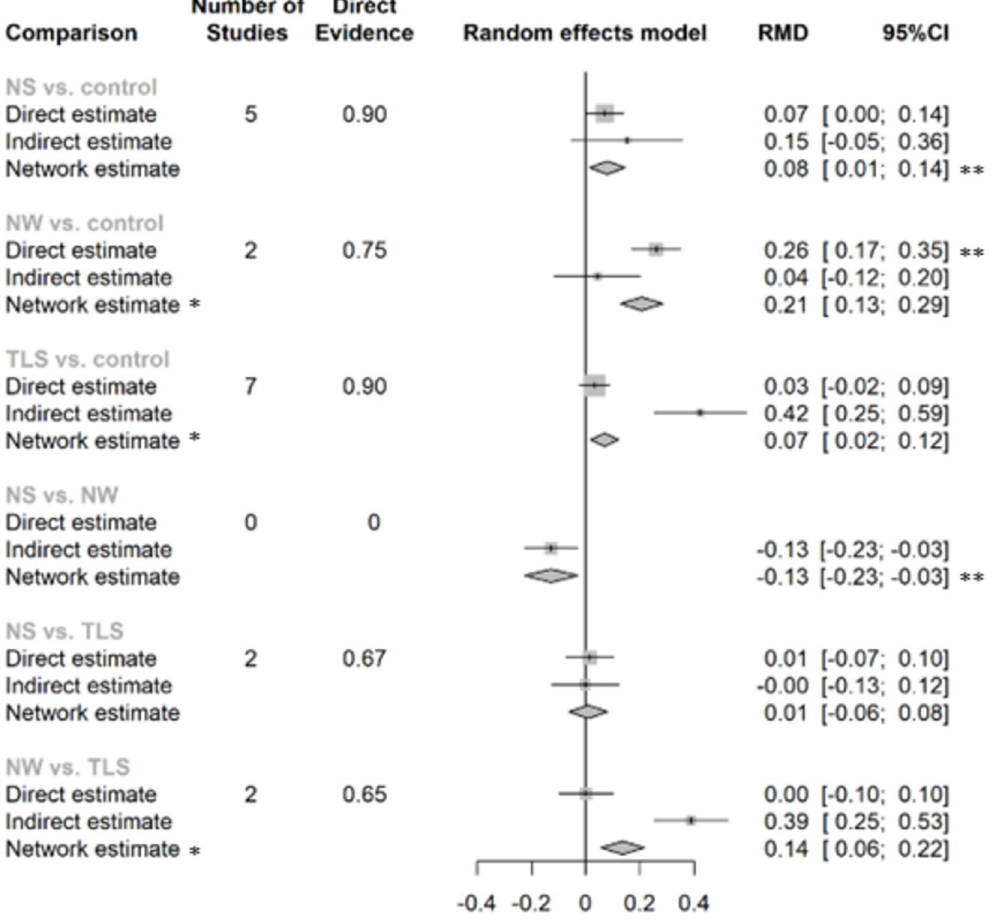
Fig 5. The network effects of different label types on the overall healthfulness purchased/chosen (RMD and 95%CI). RMD refers to the percentage of change comparing intervention with control group (RMD = (x2 − x1) / x1; x1: mean of continuous outcome in the intervention group or after implementation of intervention, x2: mean of continuous outcome in the control group or before implementation of intervention). � The direct and indirect effects were observed significantly inconsistent ( p < 0.05), and the network estimate may violate the assumption of consistency and transitivity of NMA, thus only direct evidence was used for interpretation. �� Estimates with significant effect given α = 0.05 and β = 80%. CI, confidence interval; HW, health warning; NMA, network meta-analysis; NS, Nutri-Score; NW, nutrient warning; RMD, relative mean difference; TLS, traffic light labelling system.